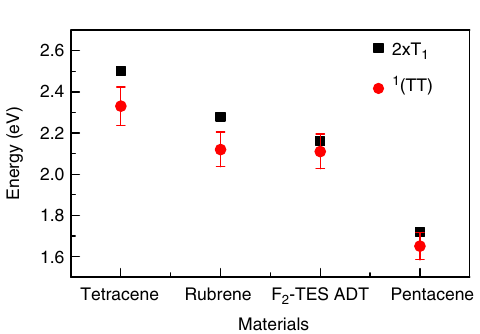
Figure 4 | 1 (TT) energies. 1 (TT) and 2 (cid:2) T 1 energies for materials studied here: 1 (TT) energy extracted from PL spectra, see Supplementary Fig. 1, T 1 from phosphorescence measurements (F 2 -TES ADT, rubrene Supplementary Figs 2, 3) and literature 61,73 . Error bars reflect uncertainty in fitting the 1 (TT) vibronic